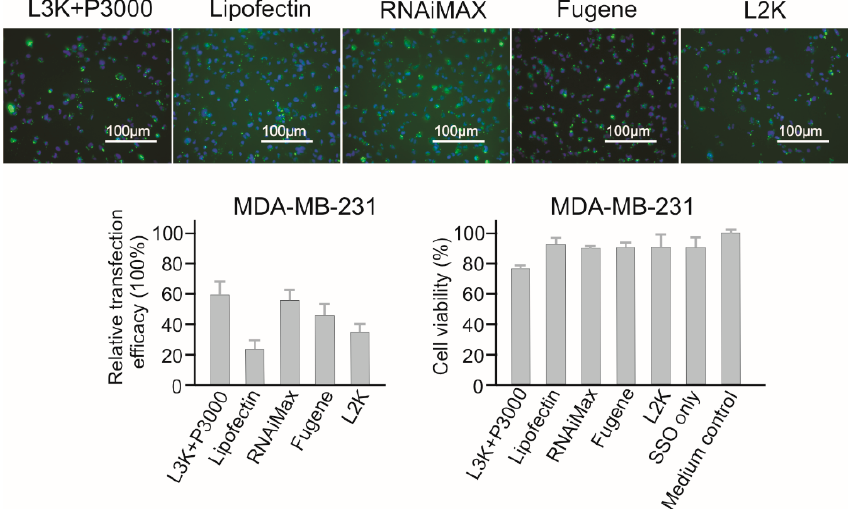
Figure 11. In vitro transfection efficiency and cytotoxicity of different transfection reagents in MDA-MB-231 cells. L3K: Lipofectamine 3000, L2K: Lipofectamine 2000. While Lipofectin (23.73%) did not perform well, Lipofectamine 2000 (33.08%) displayed a